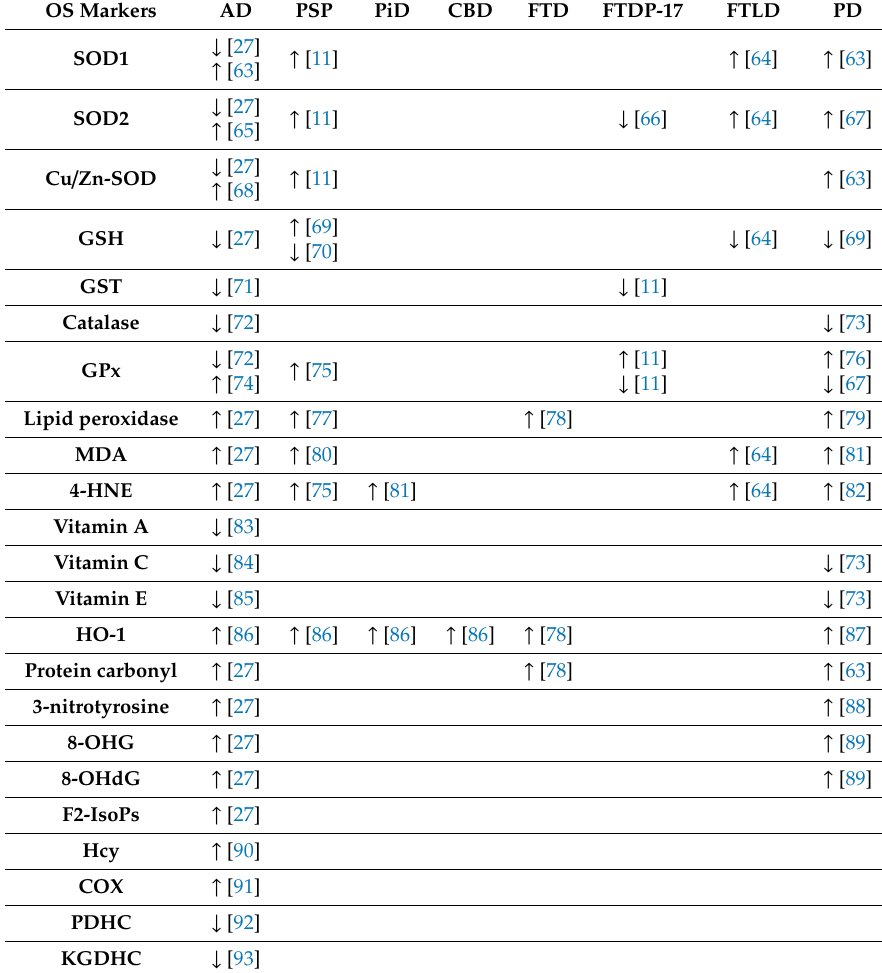
Table 1. Potential oxidative markers in tauopathies (up-regulation is labeled as up-arrow, and down-regulation is labeled as